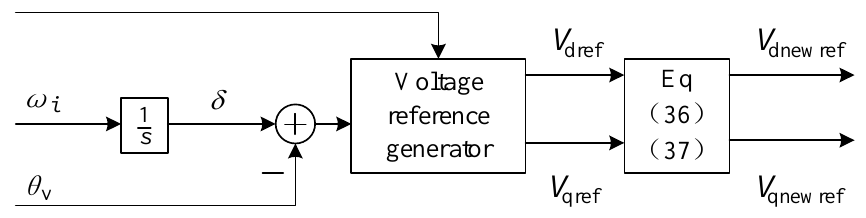
Figure 9. Voltage reference generator block.